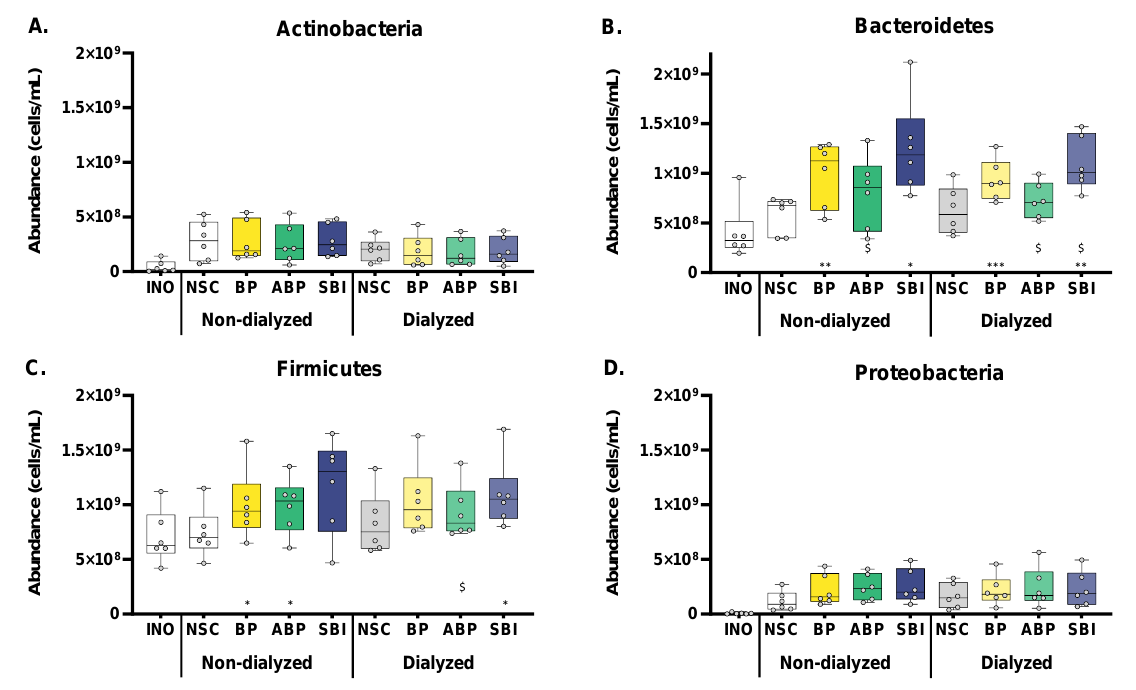
Figure 3. Three bovine plasma protein fractions (BP, ABP and SBI) stimulated Firmicutes and particularly Bacteroidetes members of the human adult gut microbiota ex vivo . The impact of three bovine plasma protein fractions, dosed at an equivalent of 5 g/day, with or without prior dialysis as a simulation of small intestinal absorption, compared to the NSC, on the abundance of ( A ) Actinobacteria, ( B ) Bacteroidetes, ( C ) Firmicutes and ( D ) Proteobacteria, as tested via the SIFR ® technology for human adults ( n = 6). Samples were collected after 0 h (INO) and 48 h of simulated colonic incubations. Statistical differences between treatments and the NSC are indicated with * (0.01 < p ad- justed < 0.05), ** (0.001 < p adjusted < 0.01) or *** ( p adjusted < 0.001), while differences between protein frac- tions ABP/SBI and fraction BP are indicated with $ (0.01 < p adjusted < 0.05). BP = bovine plasma, ABP